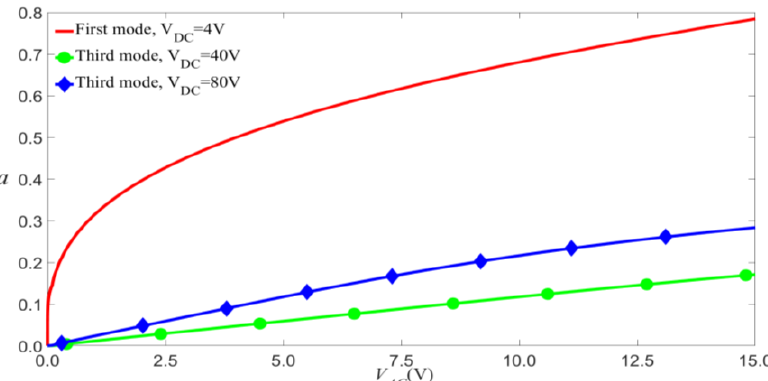
Figure 3. Amplitude of the response as a function of the load’s amplitude of primary resonance for σ = 0.